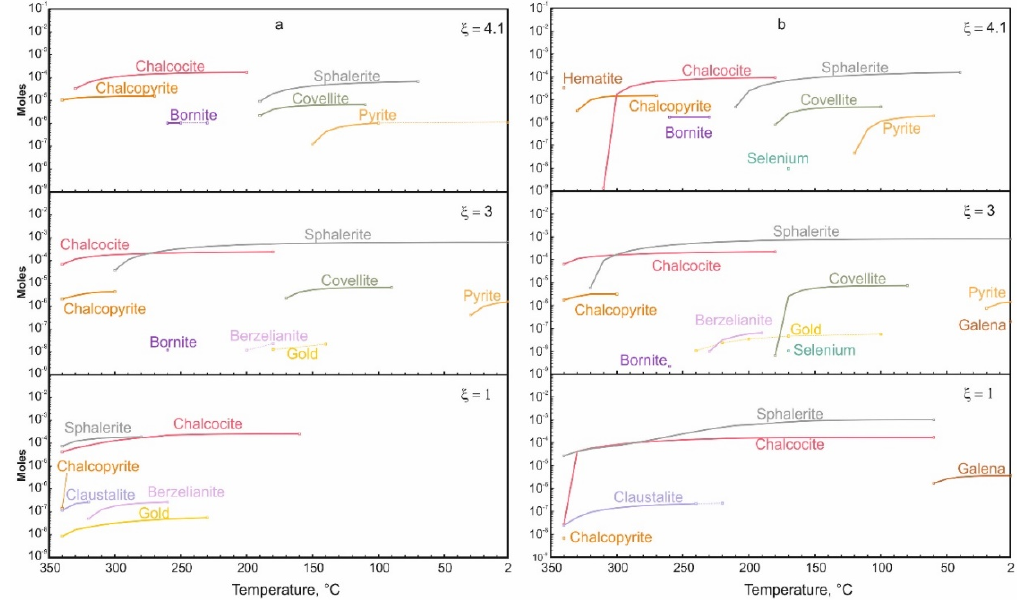
Figure 7. Calculated mineral assemblages precipitated as a result of MS/SW interaction and conductive cooling for various MS/SW ratios: scenario 1 ( a ) and scenario 2 ( b ) ; the figure shows only areas with decreasing temperature). Dotted line, the mineral is absent in the corresponding range.